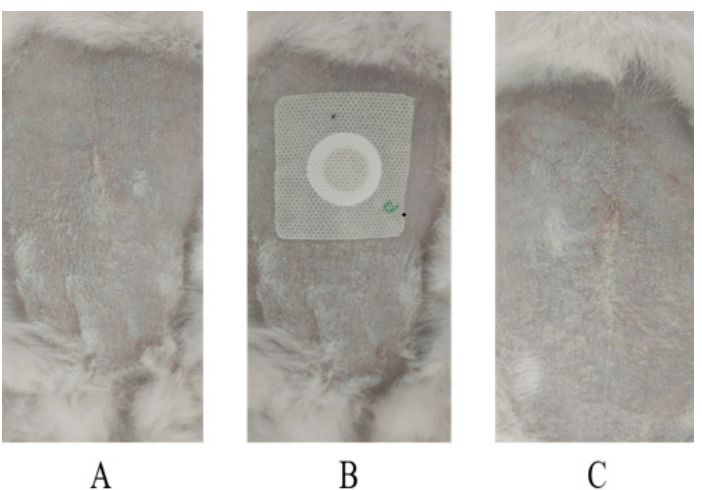
Table 4. Results of skin irritation (n = 6).